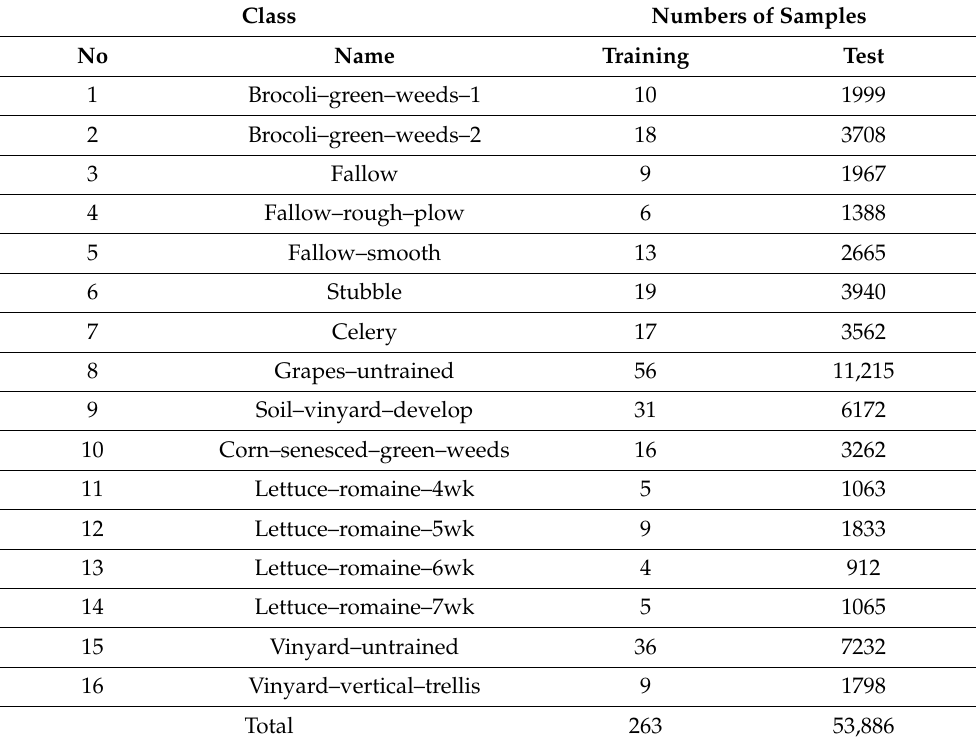
Table 5. Number of training and test samples in the SV data